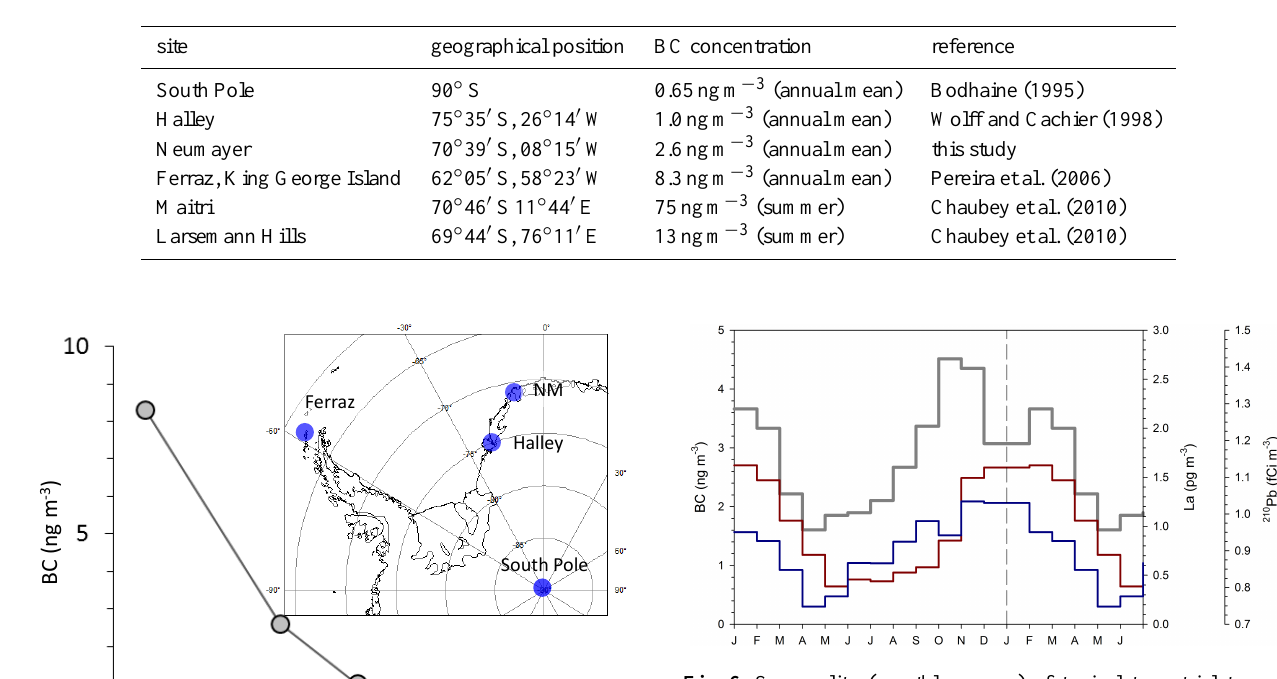
Fig. 6. Seasonality (monthly means) of typical terrestrial tracers measured at NM: BC (grey line, measured by the MAAP), the rare earth element La (red line), a tracer for mineral dust, and 210 Pb (blue line) a progeny of the terrigenous noble gas 222 Rn. The graph comprises 18 months starting from January to show the seasonal maxima without